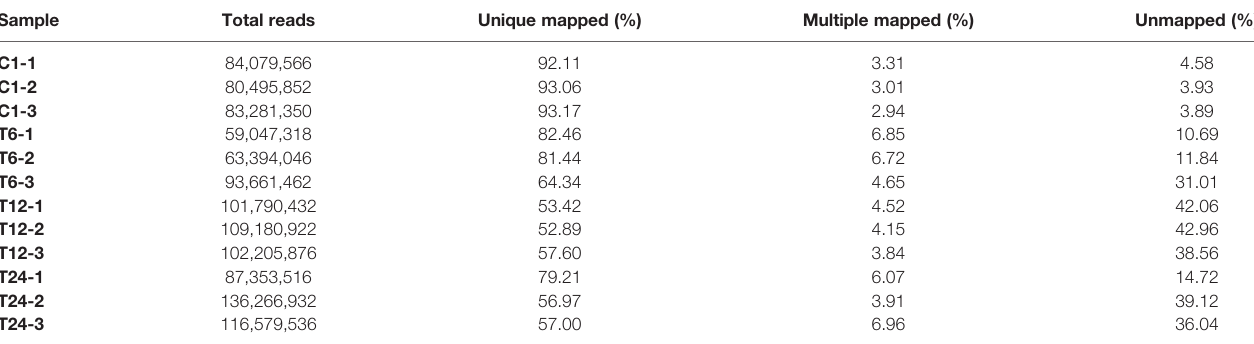
TABLE 3 | Statistical results for mapping the trimmed reads with the channel cat fi sh reference genome.